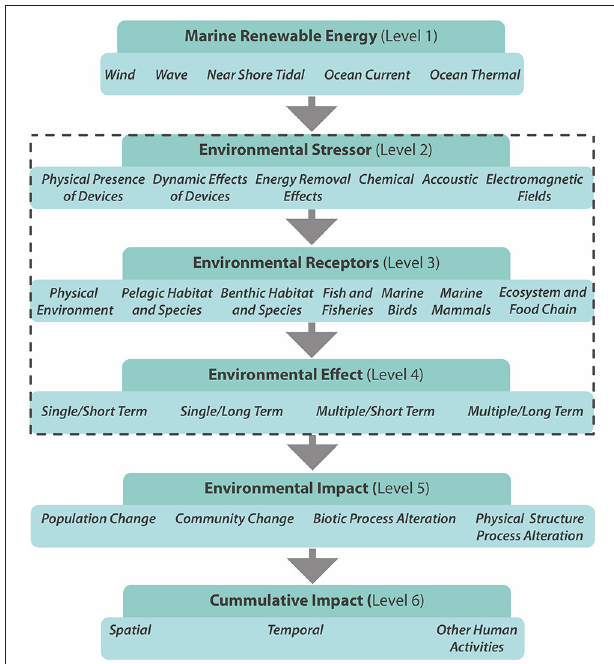
FIGURE 3 | Framework for the consideration of environmental effects of marine renewable energy encompassing different scales (Figure: adapted from Boehlert and Gill, 2010). The dashed rectangle highlights the levels at which biomonitoring is most applicable. Level 2 summerizes some of the potential environmental stressors, which can effect receptors (physical, chemical, and biological) of level 3. Level four differentiates the duration and nature of the environmental